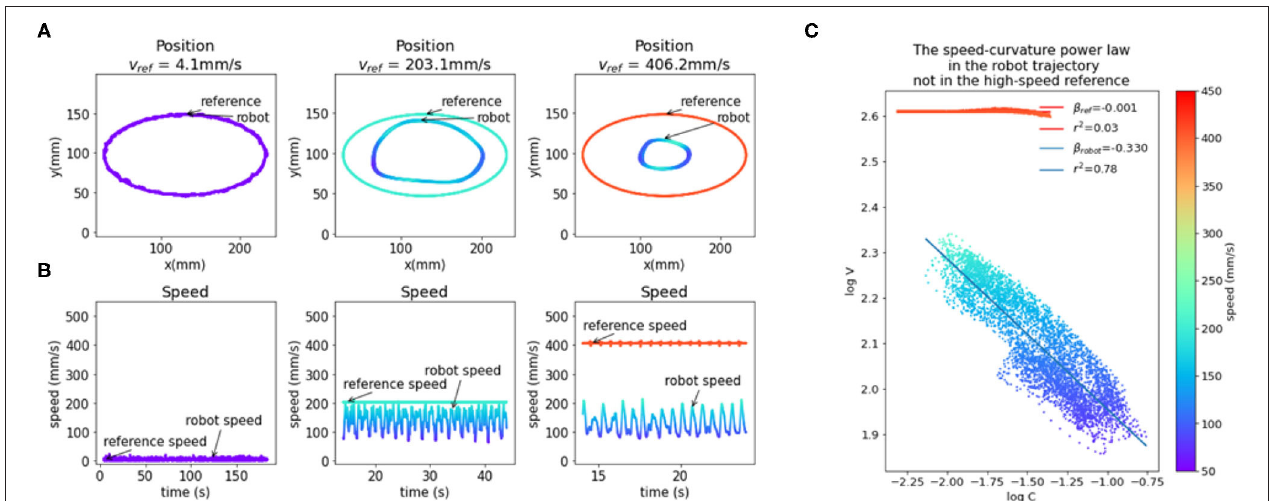
FIGURE 4 | The emergence of the speed-curvature power law at high speed. (A) Reference and robot positions. When the reference speed is low, the position of the robot hand tip marker in visual space matches the speed of the reference. At higher speeds, there is a magnitude attenuation—the ellipse shape is smaller. (B) Plot of reference and robot speeds. At low speed, the robot speed matches the reference. When the reference speed is high, the speed of the robot is lower and oscillates, even though the input speed is constant. (C) Oscillations in robot speed for the highest speed input are regular and correlated with local curvature of movement, following the speed-curvature power law with the exponent of β ≈ − 1/3 and r 2 = 0.78. The reference speed is constant (400 mm/s), and there is no power law ( β ≈ 0, r 2 ≈ 0). In all the plots colors indicate speed, as shown in the color bar on the right. Position data were smoothed with a 2nd order Butterworth filter with a 3Hz cutoff and differentiated to generate speed